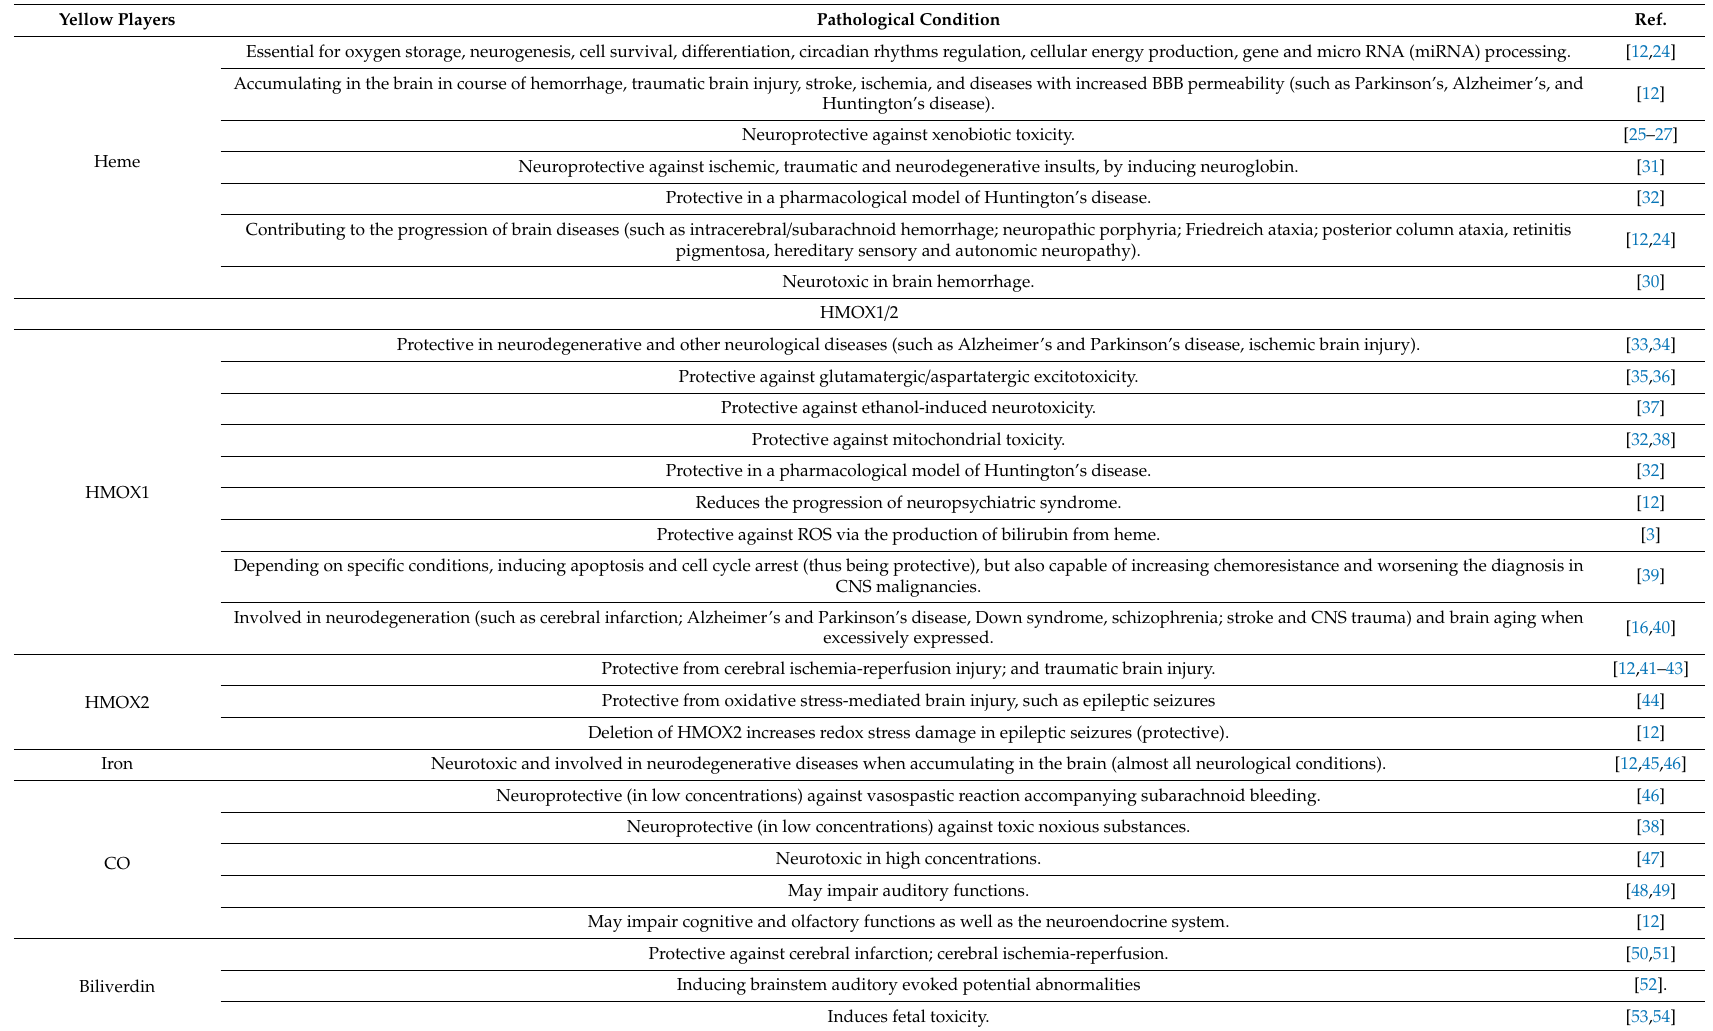
Table 1. Association of the yellow players (YPs) with brain diseases. Yellow Players Pathological